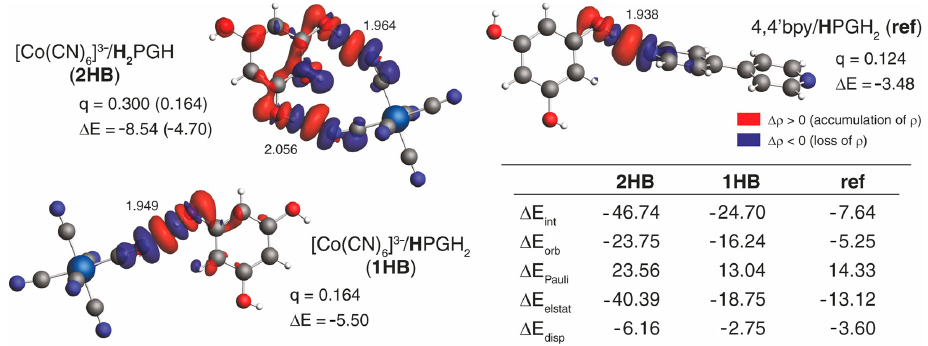
55555 Figure 5. Results of ETS-NOCV analysis of the interaction between [M(CN) 6 ] 3 − anion and H 3 PG molecule in {[Co(CN) 6 ] 3 − ; H 2 PGH} and {[Co(CN) 6 ] 3 − ; H PGH 2 } molecular clusters extracted from the crystal structure of 3 and between 4,4 (cid:48) -bipyridyl (4,4 (cid:48) bpy) and H 3 PG in {4,4 (cid:48) bpy; H PGH 2 } molecular cluster extracted from the crystal structure reported in Ref. [64] used here as a reference. Isosurfaces ( ± 0.0005 au) of dominant NOCV contributions to the differential electron density ∆ ρ describing hydrogen bonding along with their charge (q in e) and orbital energy ( ∆ E in kcal mol − 1 )